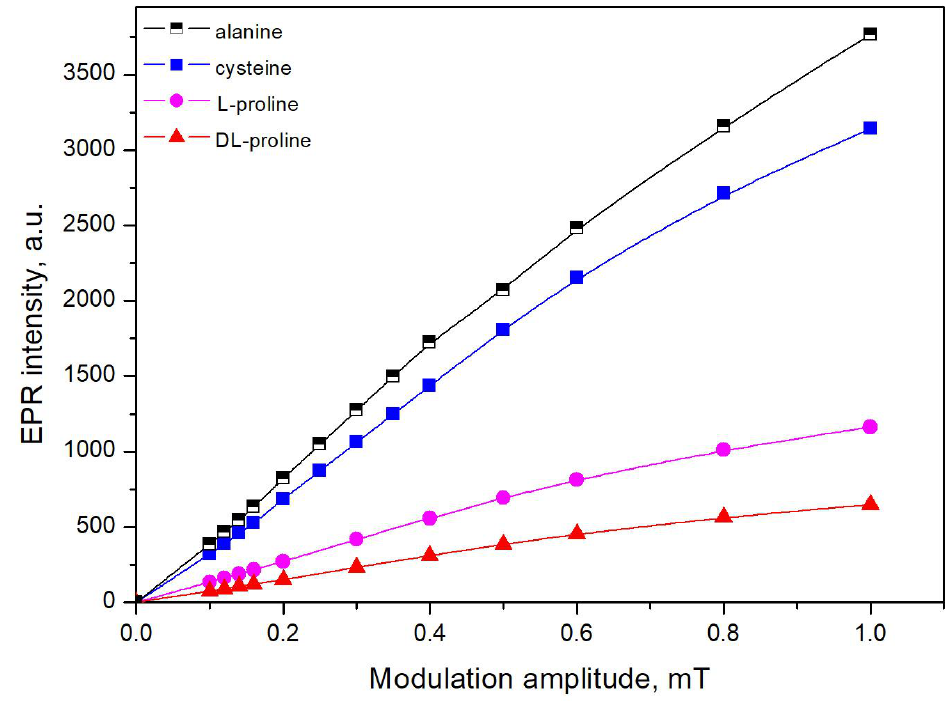
Figure 5. The dependence of the EPR signal intensity on the modulation amplitude.